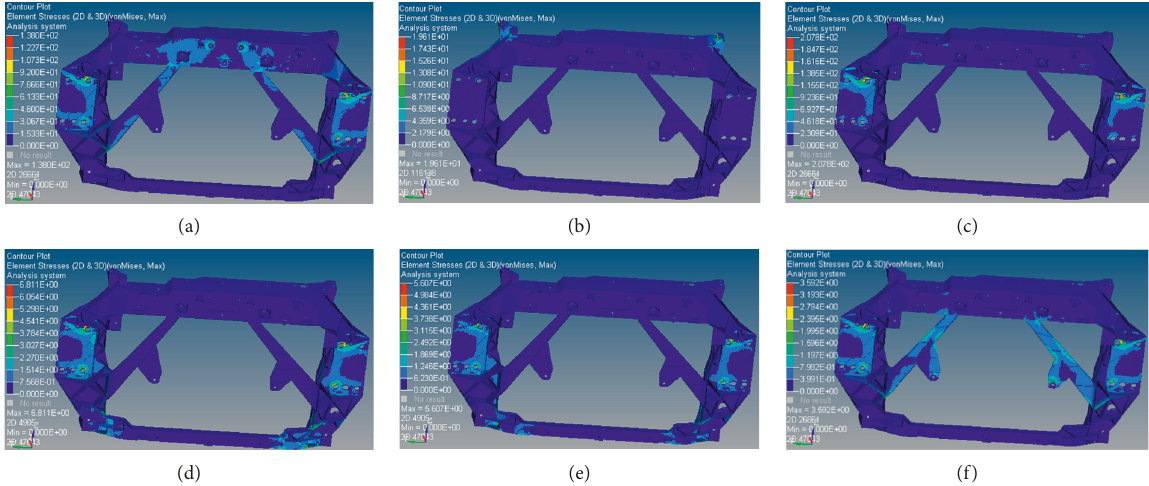
Figure 21: Front-end framework stress cloud. (a) Cloud diagram of ultimate tensile stress of lock; (b) impact stress cloud diagram of cushion; (c) cloud map of pedestrian impact stress; (d) stress cloud diagram of condenser support strength; (e) stress cloud diagram of radiator support strength; and (f) oil cooler installation strength stress cloud diagram.